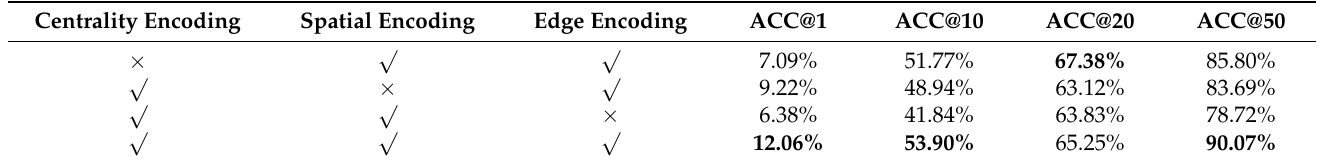
Table 5. Ablation experiment results on the Facebook–Twi tt er dataset. Table 6. Ablation experiment results on the Weibo–Douban